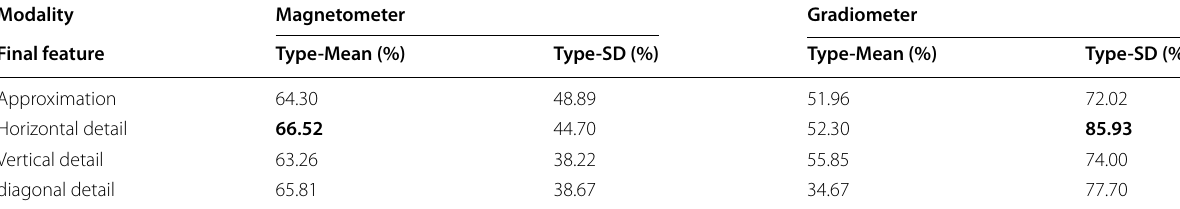
The optimal features and performances are highlighted in bold